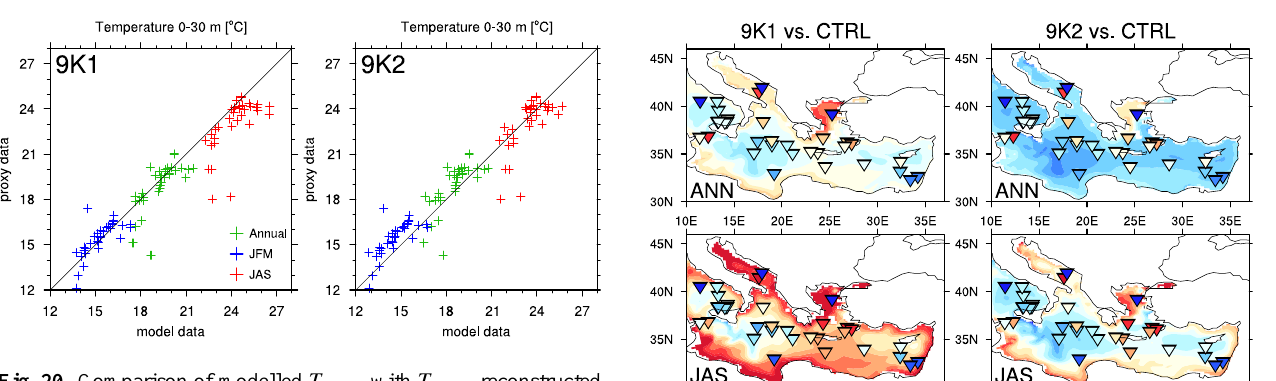
Fig. 20. Comparison of modelled T 0 − 30 with T 0 − 30 reconstructed from proxy data (Kucera et al., 2011) for 9K1 (left) and 9K2 (right). Annual mean, winter (JFM) and summer (JAS) are considered.